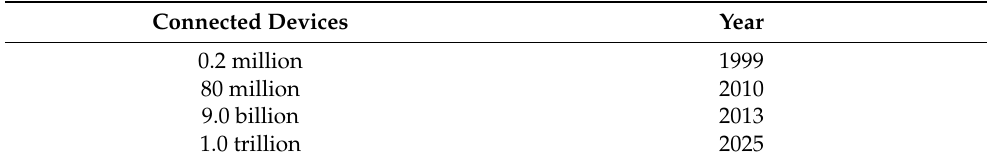
Table 10. IoT devices connected